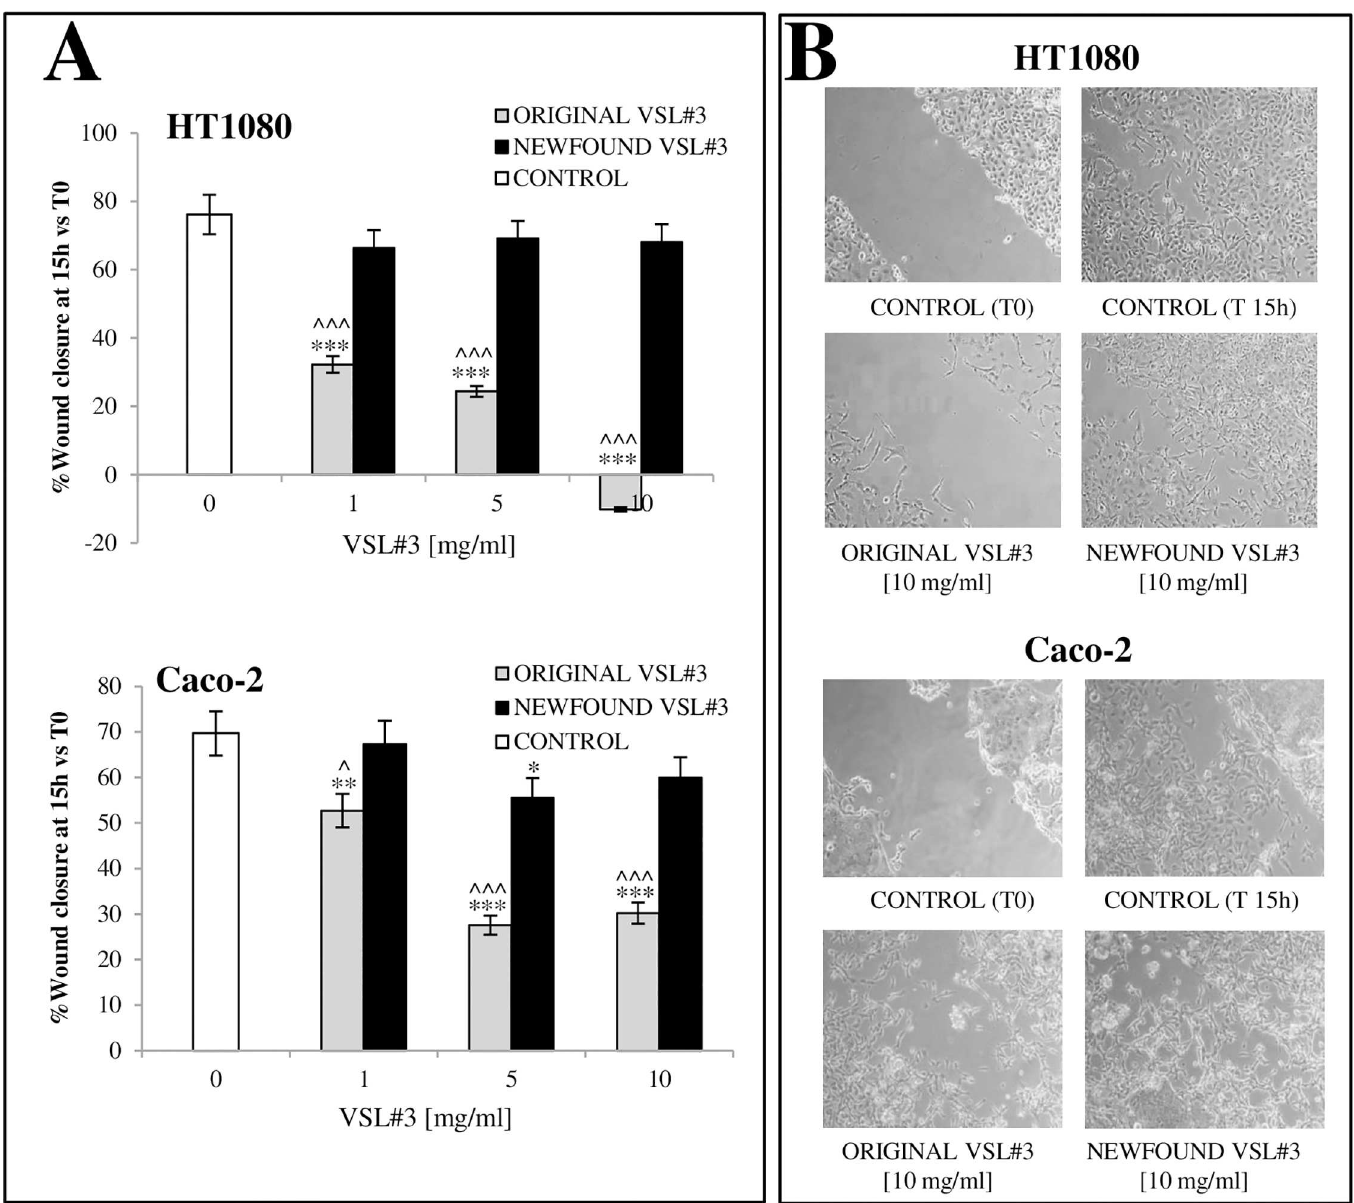
Fig 4. A) Comparison between the effects of bacterial lysates on proliferation/migration ability of tumor cells assayedthrough in vitro “wound healing model”. The effect of bacterial lysates at 1, 5, and 10 mg/ml on the resurfacing of scratched monolayerswas analyzedand compared to the relative control cells. The microscopy images acquired for each sample were analyzedwith TScratch software to automatically quantify the percentageof wound closure. Data are presented as the mean of duplicatevalues ± SD) and are relative to % wound closure at 15 h from monolayerscratching. The results shown are representative of 3 independent experiments. * P < 0.05, ** P < 0.01, and *** P < 0.001 vs untreated control; ^ P < 0.05 and ^^^ P < 0.001 vs “newfound VSL#3” lysate treatment. B) Representative microscopy images of monolayers after treatment with “original” and “newfound